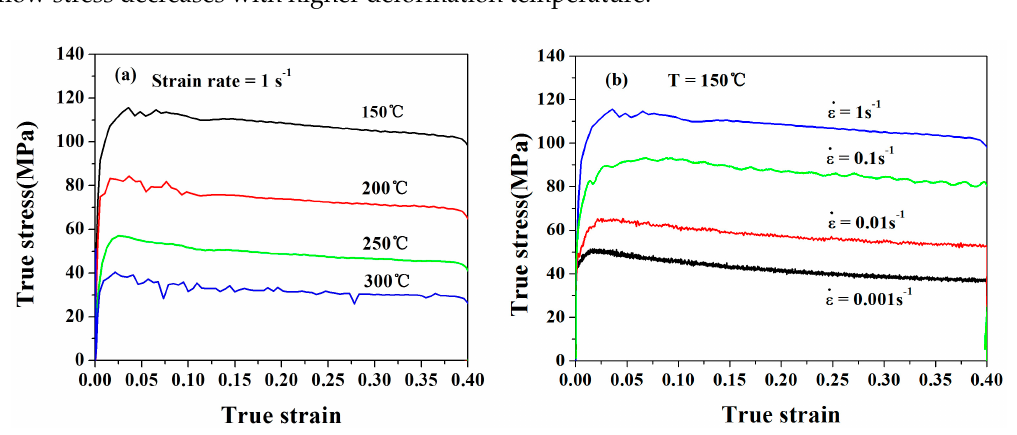
Figure 4. True stress–strain curves for Mg-Li alloy under different deformation conditions: ( a ) The stress–strain curves obtained under strain rate of 1 s − 1 with different temperatures of 150 °C, 200 °C, 250 °C and 300 °C; ( b ) The stress–strain curves obtained under 150 °C with strain rates of 1 s − 1 , 0.1 s − 1 , 0.01 s − 1 and 0.001 s − 1 .